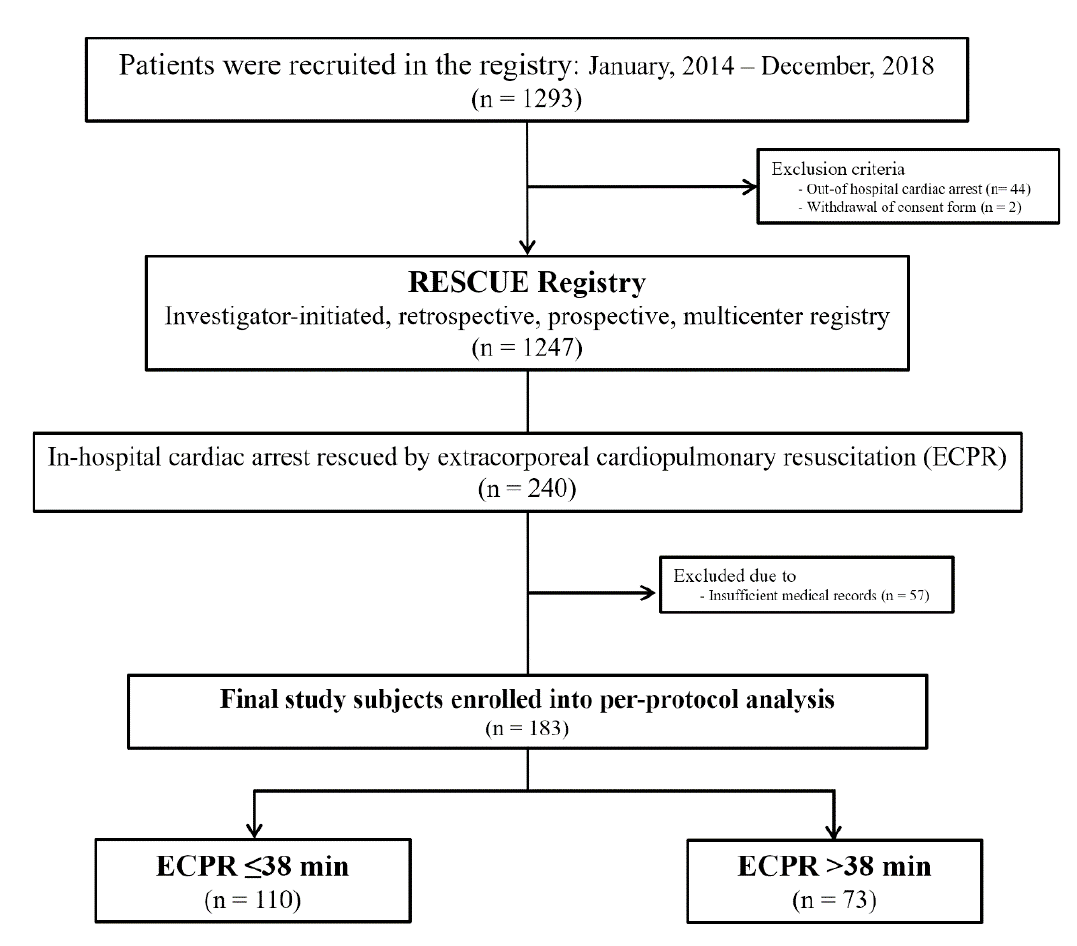
Figure 1. Schematic illustration of study cohort selection.